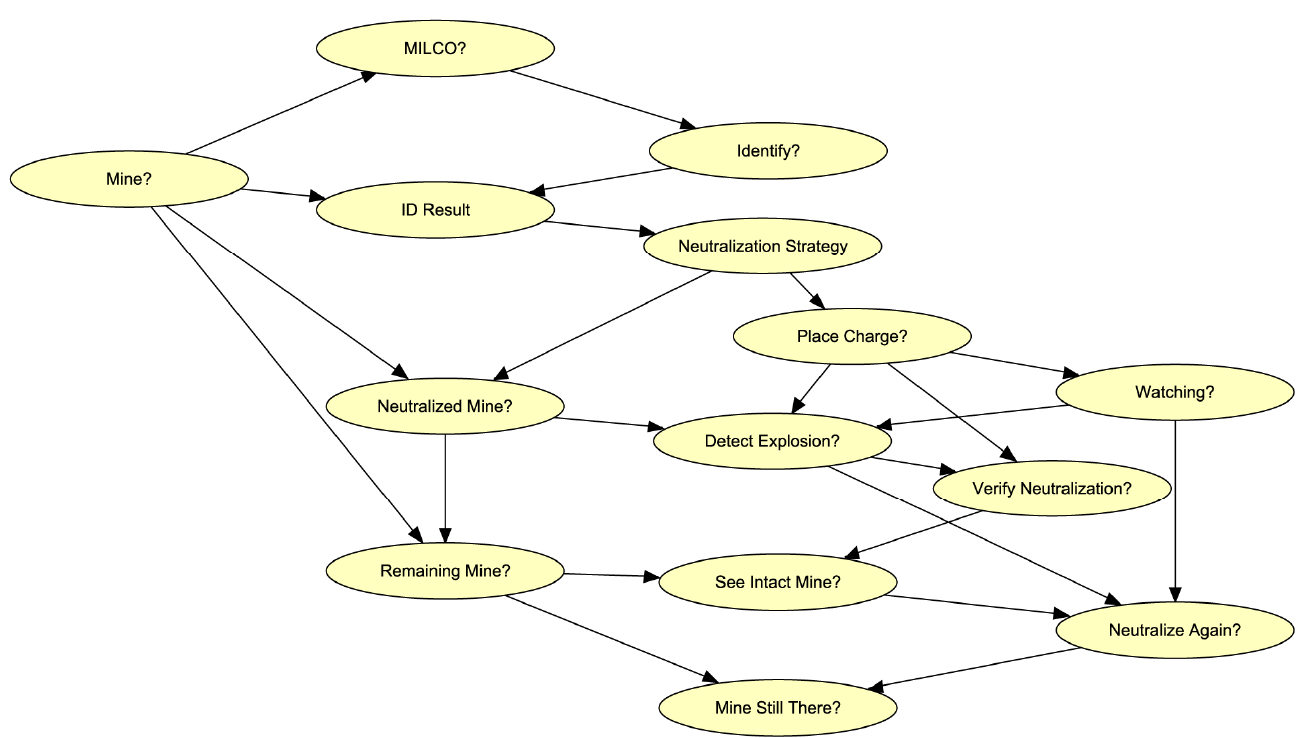
Figure 2. This directed acyclic graph provides both the discrete random variables (represented as yellow ellipses) used to model inference within each grid cell and the causal relationships between them (represented with arrows). The graph forms the basis of a Bayesian network. That network uses the convention that Boolean random variables have names ending with a question mark. Table 2. This table provides a glossary of network parameters. Those above the solid line control the performance of sensors and processes, while those below are used to predict the decisions of mine warfare officers (in simulation). These decisions concern which MILCOs to identify, which identified mines to neutralize (and how to do it), whether to investigate further and whether to retry neutralization (when it might have